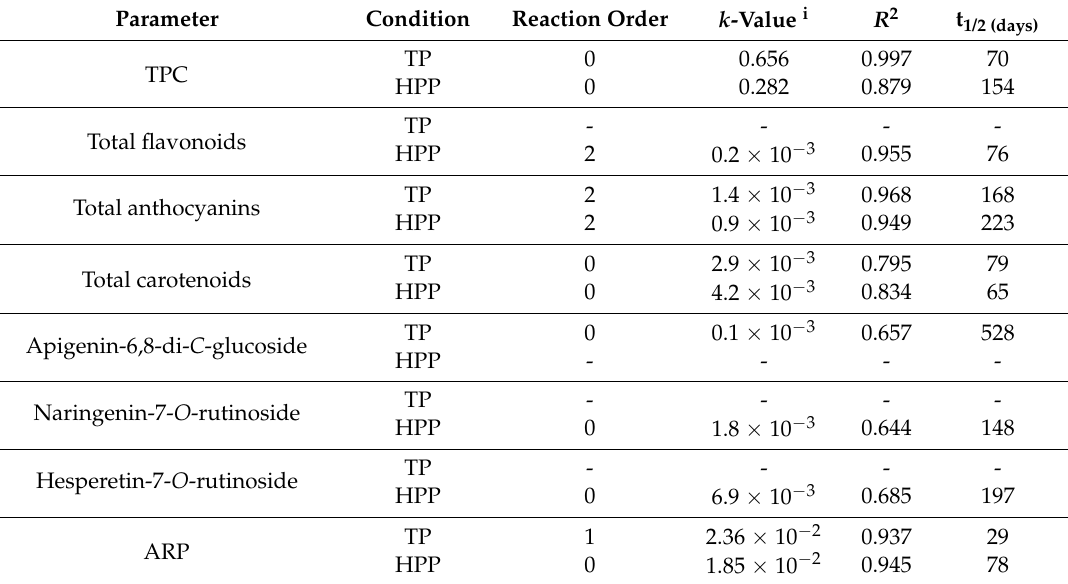
Figure 6. Individual phenolic compounds content (mg/100 mL) of fresh and thermal pasteurized (TP) orange juice during storage at 4 °C.